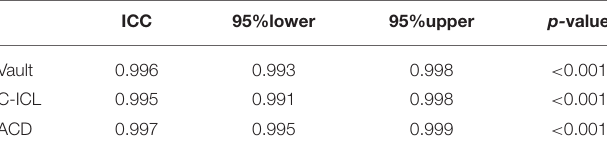
TABLE 2 | Repeatability of IOL Master 700 measurements of vault, C-ICL, and ACD.